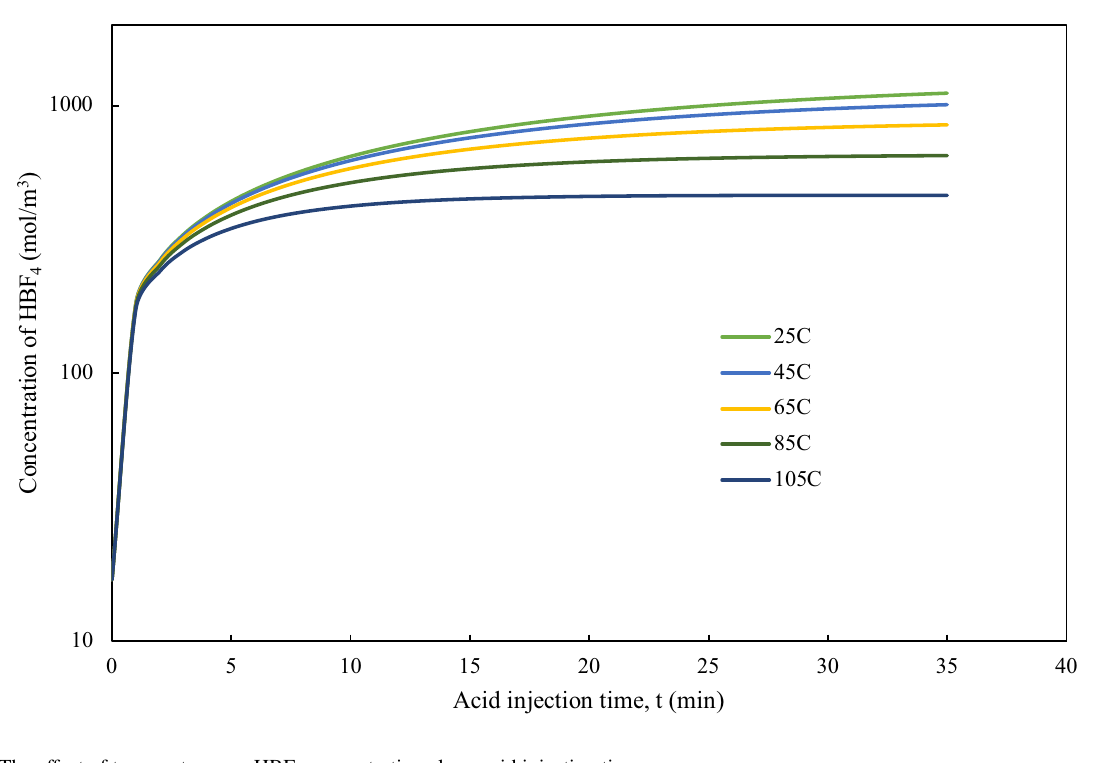
Fig. 13 The effect of temperatures on HBF